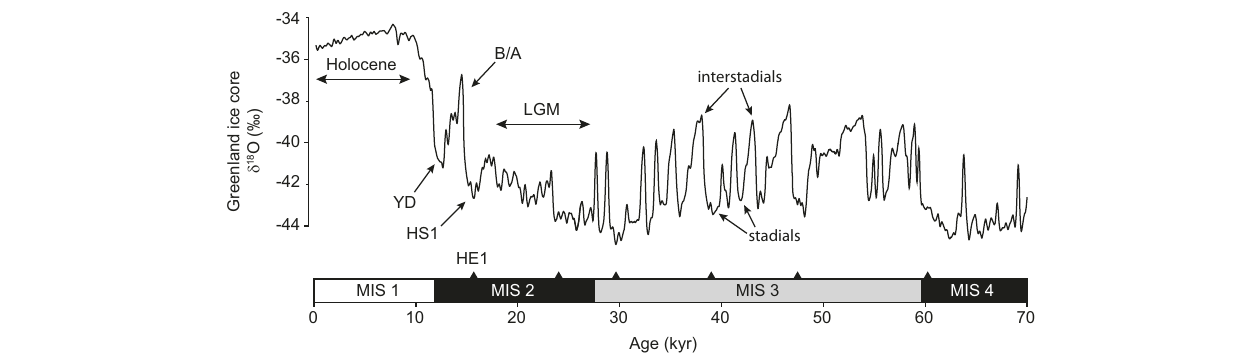
Box Figure 2 Millennial-scale climate variability as documented by Greenland ice-core δ 18 O 99 (a 1st order proxy for local temperature) reveals abrupt fl uctuations between cold (stadial) and warmer (interstadial) conditions. YD Younger Dryas, B/A Bølling-Allerød, HS1 Heinrich Stadial 1, LGM Last Glacial Maximum. Black triangles represent Heinrich events (e.g.